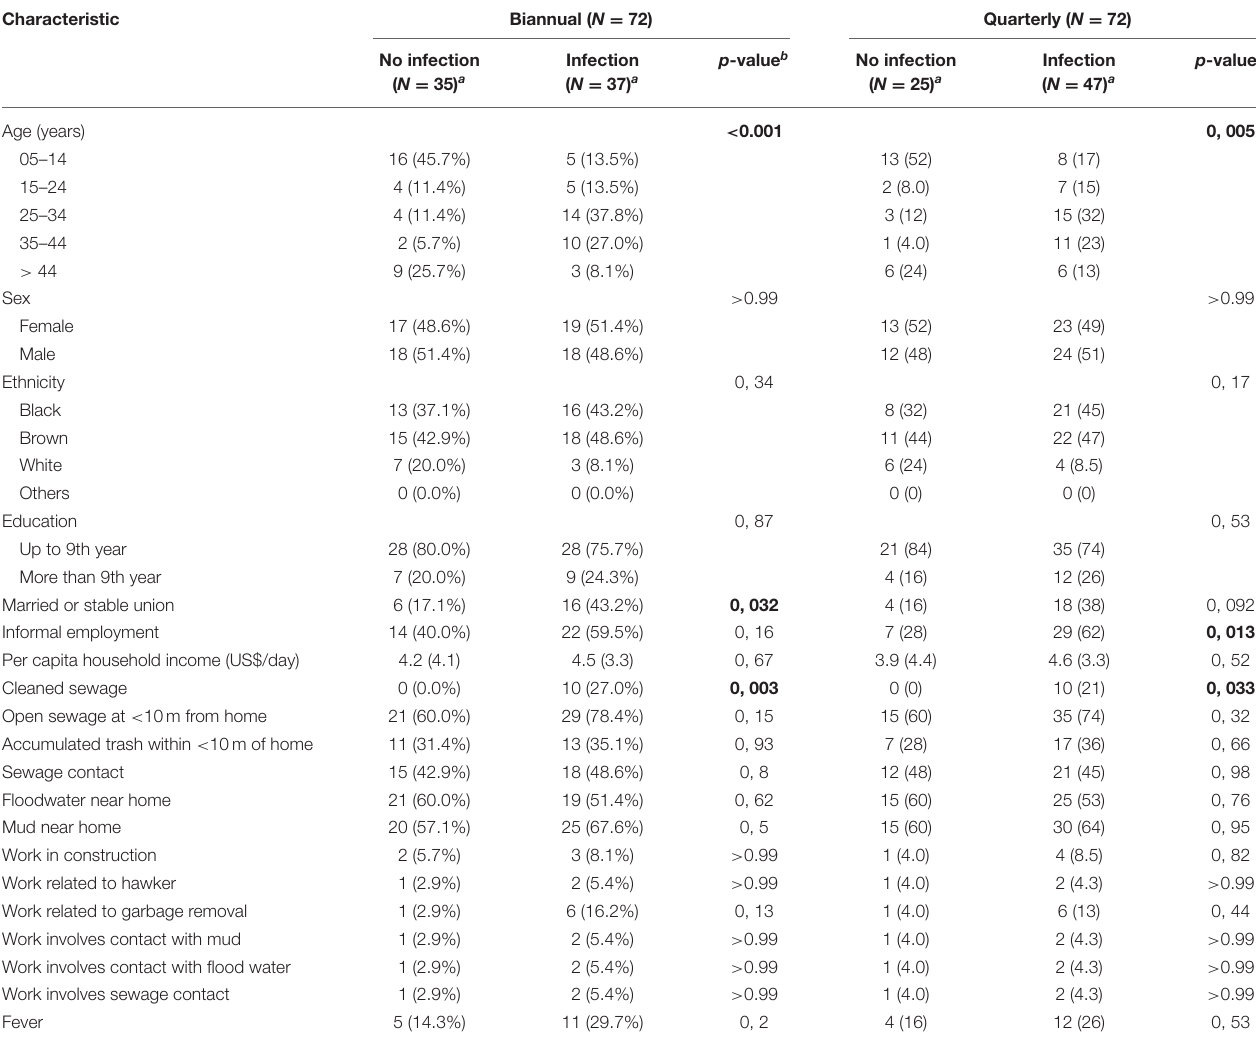
TABLE 4 | Comparison of the sociodemographic and exposure characteristics of the individuals in the subcohort based on the biannual analysis and quarterly analysis follow-up.